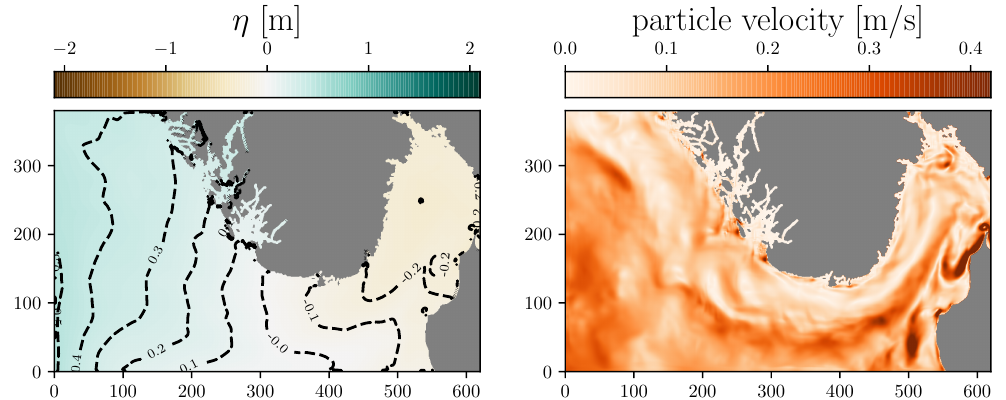
Figure 2. Example of a shallow-water simulation for oceanographic purposes with our code. The left figure shows the sea-surface level, whereas the right figure shows the particle velocity. The simulation covers the North Sea around the southern part of Norway, with Denmark in the lower right corner. The axes shows distances in km, and the grid consists of 1550 simulation here is initialized from operational data provided by the Norwegian Meteorological Institute.